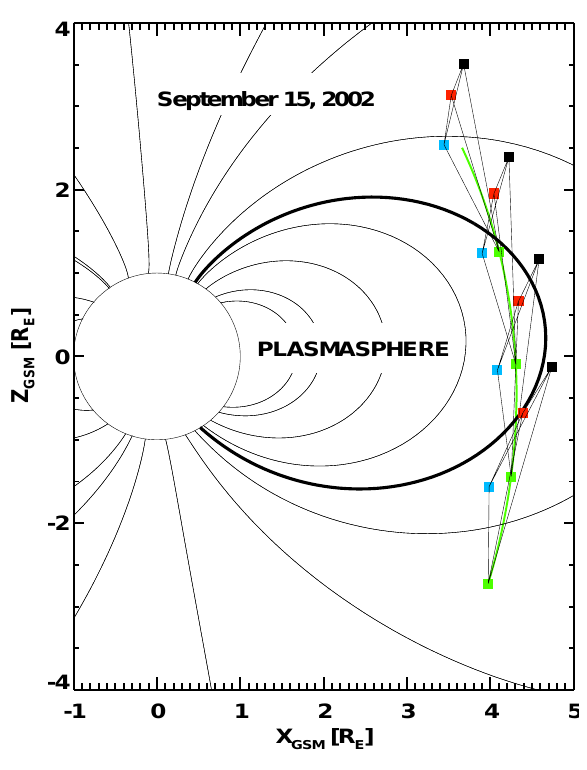
Fig. 1. The CLUSTER orbits in the dayside magnetosphere on 15 September 2002, 06:00, 07:00, 08:00 and 09:00 UT. The satel- lite move from south to north. The thick black line represents the plasmapause found at L = 4 .